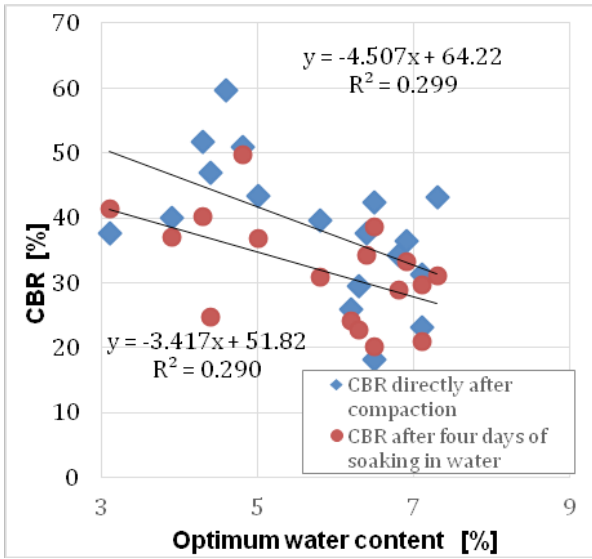
Figure. 7: Correlation between CBR value and optimum moisture content value.